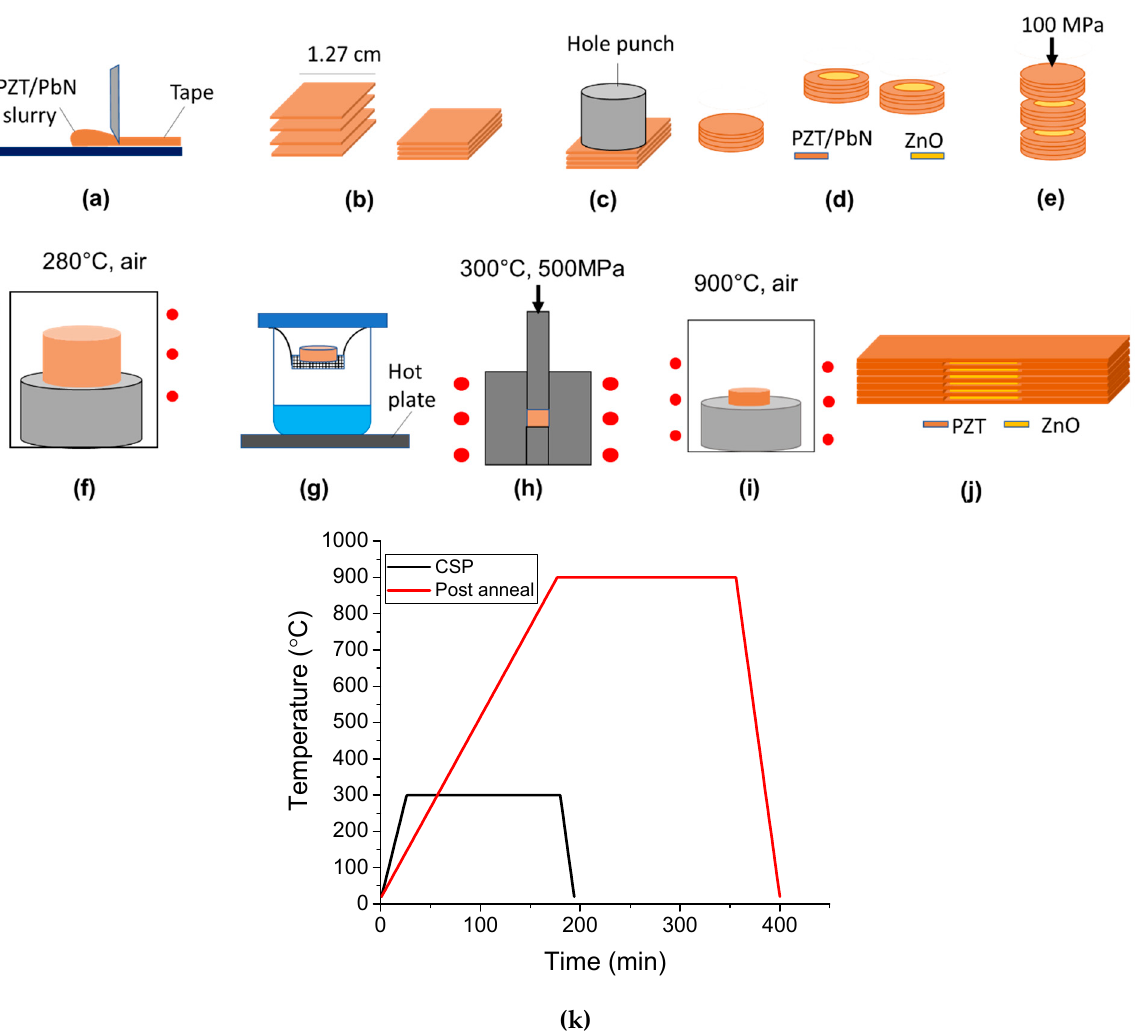
Figure 1. Fabrication process sequence for 3-0 PZT-sacrificial layer composites. The figures illustrate the following 10 steps: ( a ) casting PZT/Pb nitrate slurry into a tape; ( b ) cutting into squares with side 1.27 cm; ( c ) stacking square sheets and cutting stack into circular sheets with a hole punch; ( d ) placing sacrificial layer concentrically on the PZT tape stack; ( e ) uniaxially laminating at 100 MPa; ( f ) burning out the binder from the composite stack in a box furnace; ( g ) hanging sample in a beaker on a hot plate for steaming; ( h ) cold sintering composite sample in a die; ( i ) post annealing sample in a box furnace; ( j ) dicing post annealed sample to expose the sacrificial layers. The temperature profile for the 2-step densification of the ceramic is shown in ( k ).